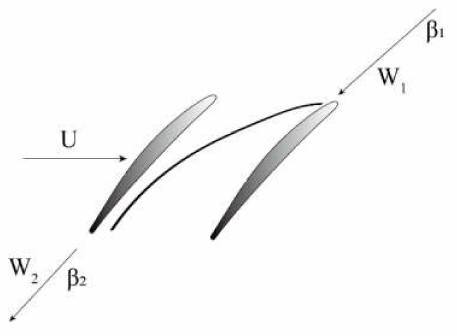
Figure 1. Flow in the elementary flow channel.